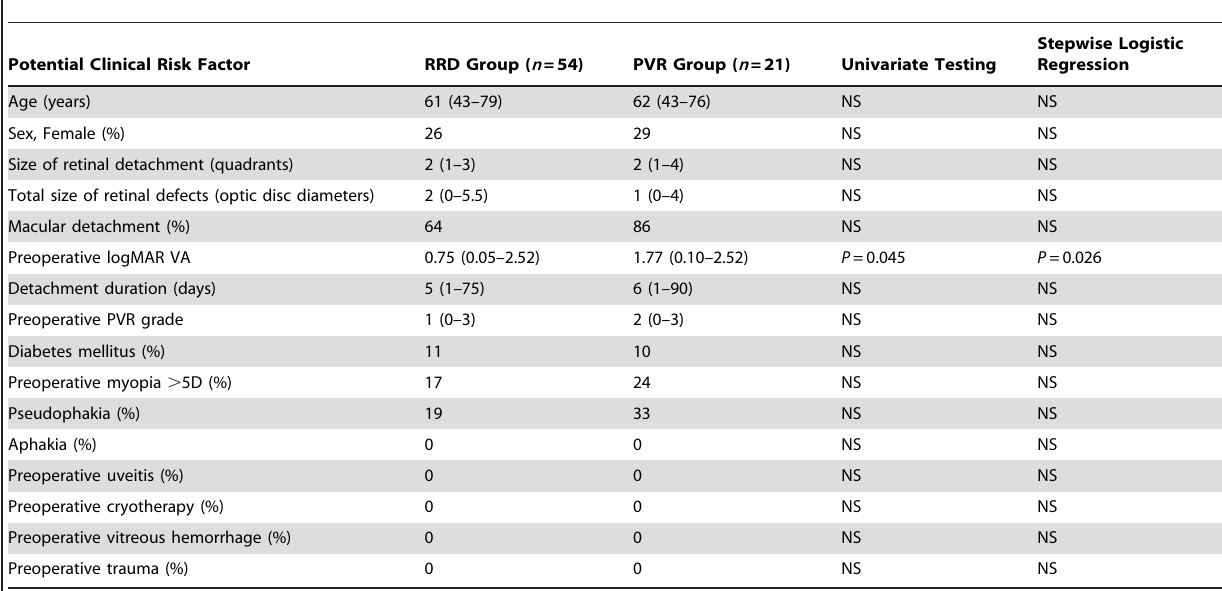
Table 1. Demographics and Potential Clinical Risk Factors for